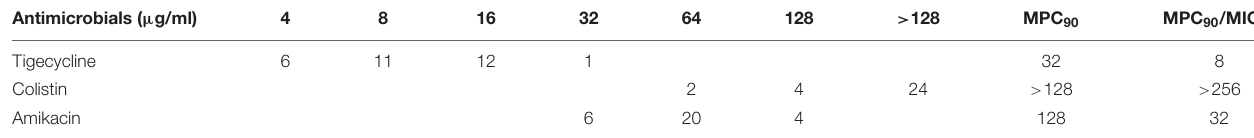
TABLE 1 | MPCs distribution of three antimicrobials alone for 30 clinical isolates of KPC-producing Klebsiella pneumoniae . Antimicrobials ( µ g/ml)